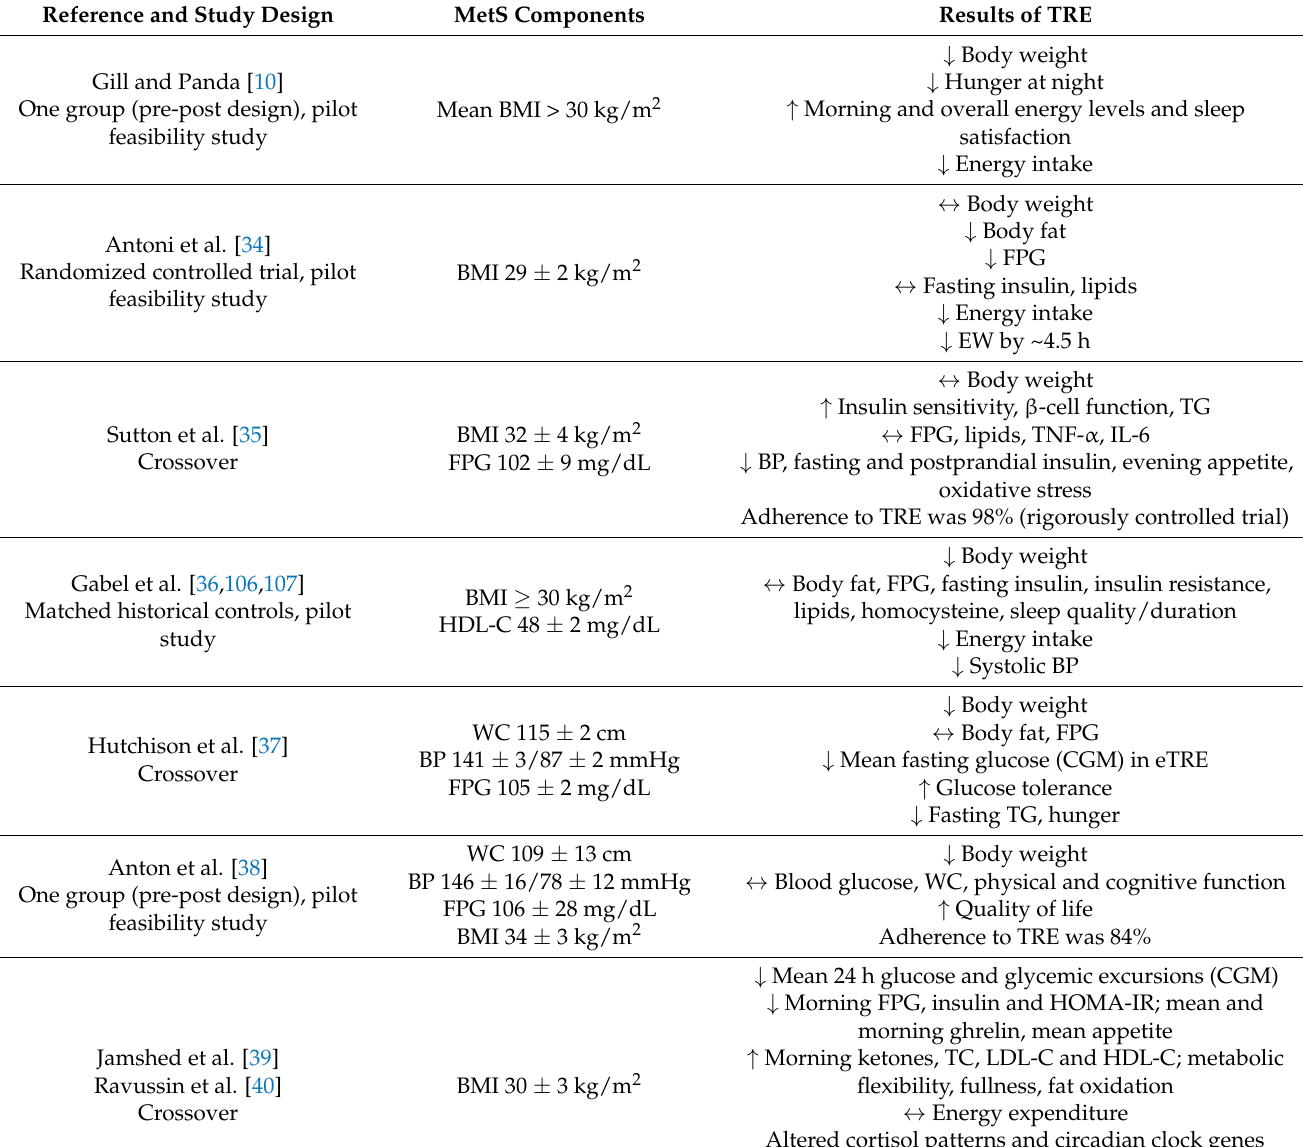
Table 2. Major findings of time-restricted eating trials in humans with metabolic syndrome or its components. Reference and Study